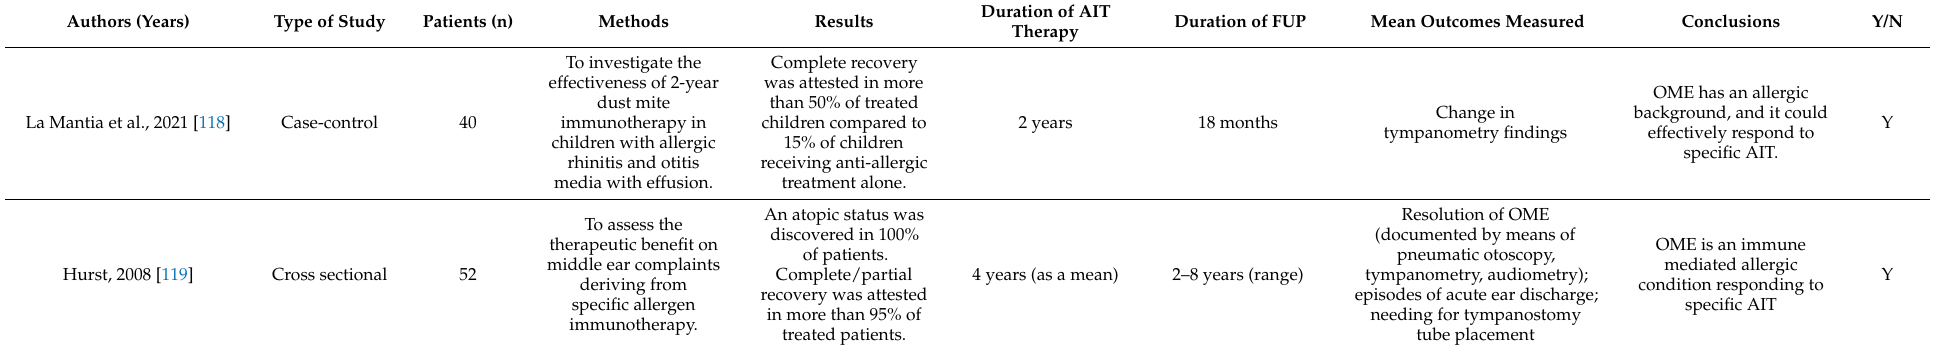
Table 4. Studies on efficacy of AIT in otitis media with